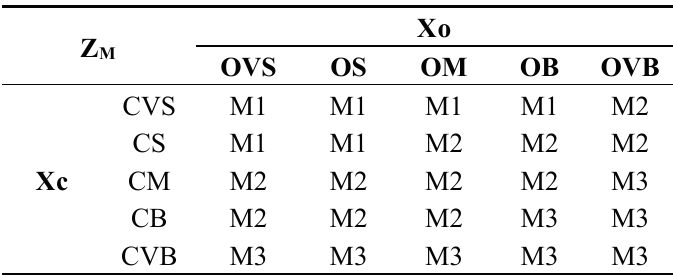
Table 3. Situational mode fuzzy rule table.